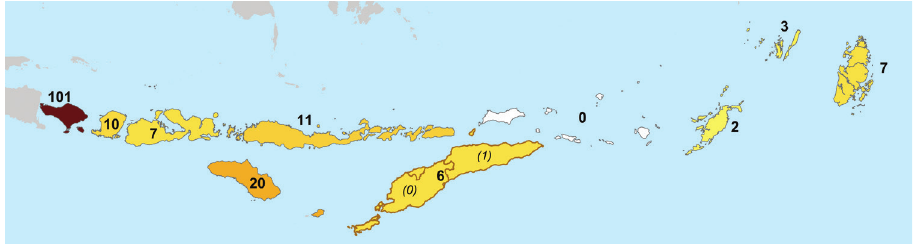
Figure 3. Number of known species from the individual islands. The darker the color, the greater the number of